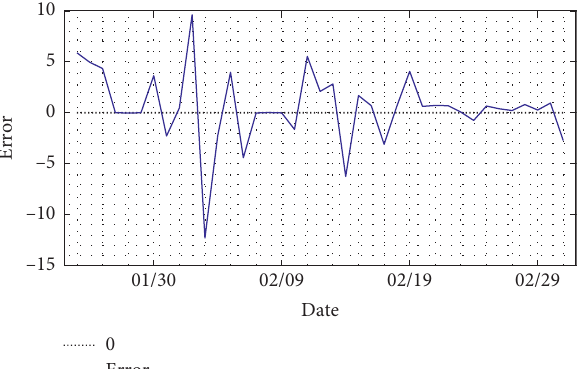
Figure 2: The fitting error of Guangdong Province, China. The mean absolute error is 2.3, indicating the goodness of